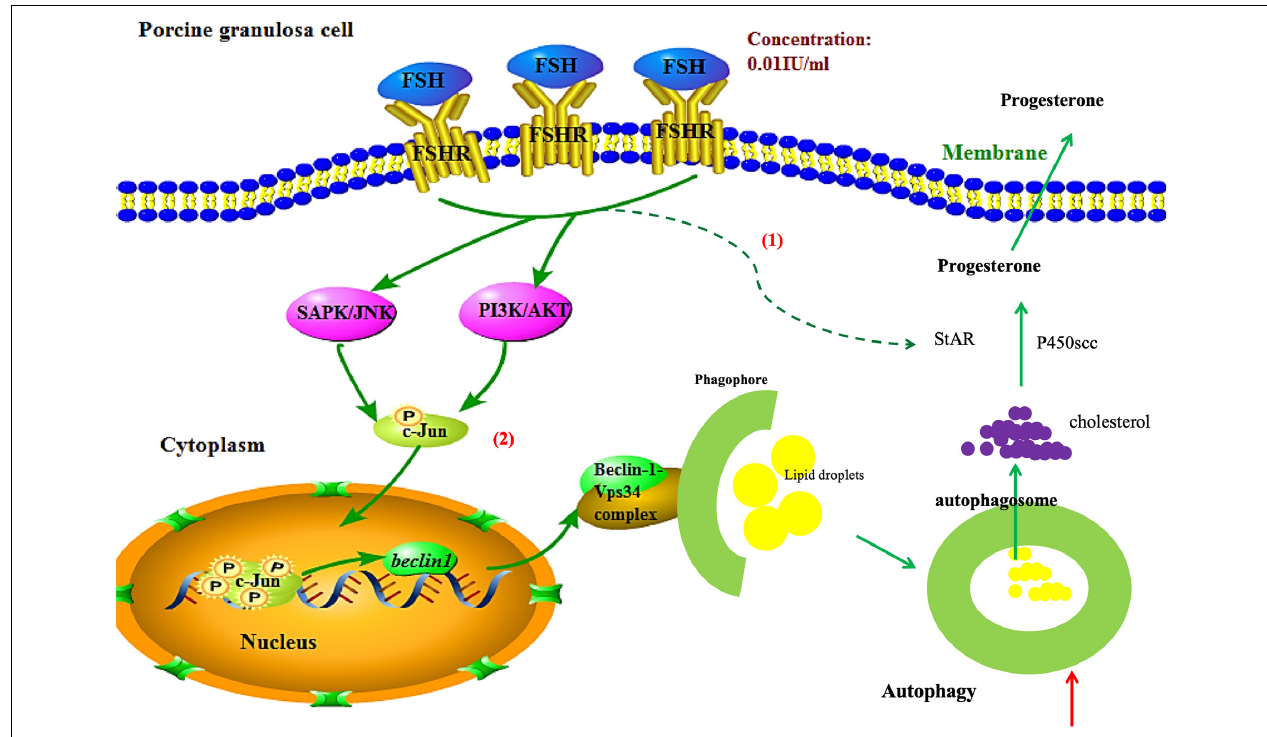
FIGURE 6 | Schematic illustration of autophagy regulation by FSH stimulation in porcine GCs. FSH promotes progesterone secretion by accentuating autophagy through upregulation of Beclin1 via the PI3K/JNK/c-Jun pathway to accelerate LD degradation and increase the expressions of steroidogenesis enzyme genes in porcine